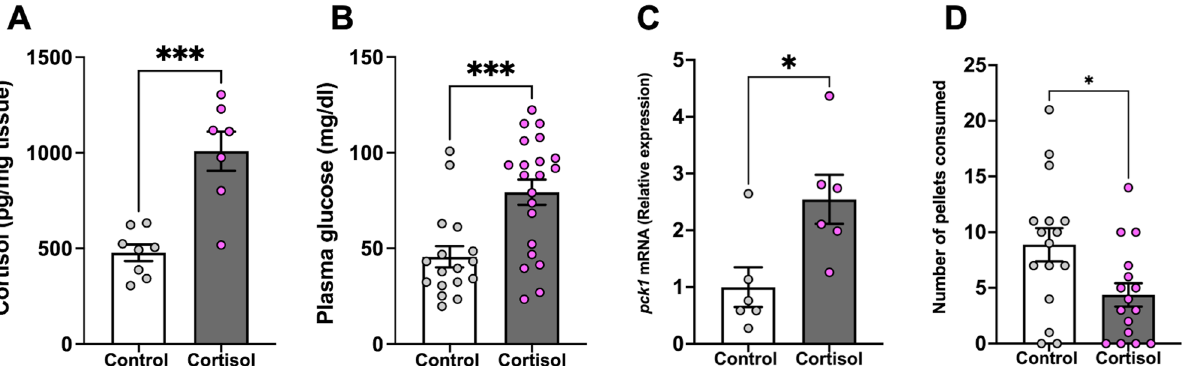
Figure 4. Cortisol suppresses feeding. ( A ) Whole-body cortisol levels were higher in the cortisol-treated fish compared to the control. ( B ) Cortisol treatment significantly increased plasma glucose levels. ( C ) The pck1 transcript abundance in the liver significantly increased after cortisol treatment compared to the control. ( D ) Cortisol-treated fish consumed significantly fewer pellets than the control. Values are means ± SEM (Whole-